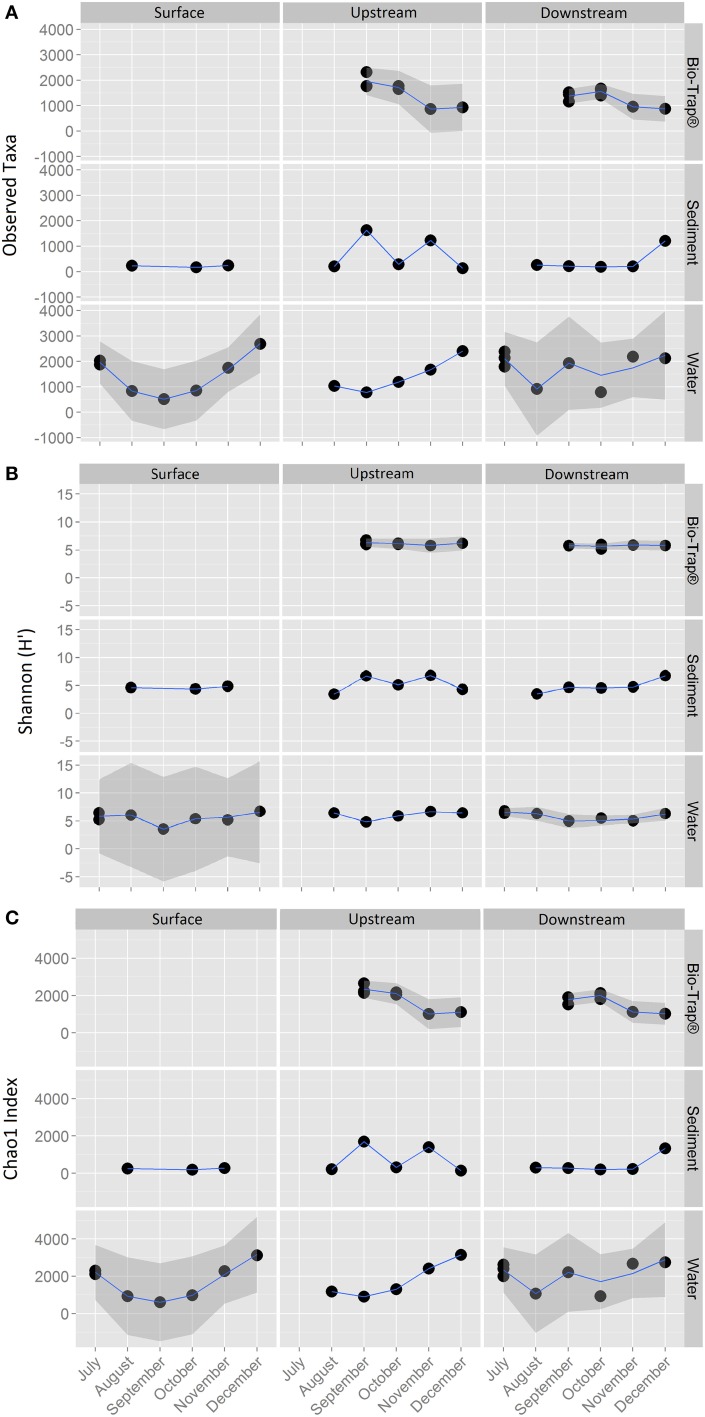
Alpha-diversity richness and evenness indices for (A) Observed, (B) Shannon, and (C) Chao1, values by sample type and location over a 6 month period.